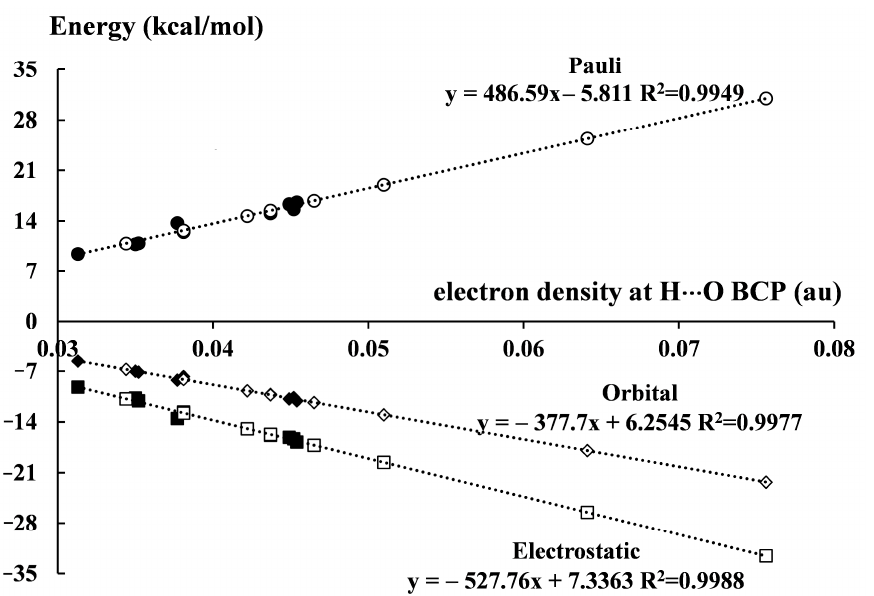
Figure 6. The relationship between the electron density at H ∙∙∙ O BCP (au) and the interaction energy terms described by Equation (5) (kcal/mol), three terms are taken into account (without dispersion term); full circles correspond to intermolecular hydrogen bonds while open circles correspond to intramolecular bonds; the energies for former interactions are those of Table 6 while intramolecular interaction energy terms are those of Table 8.